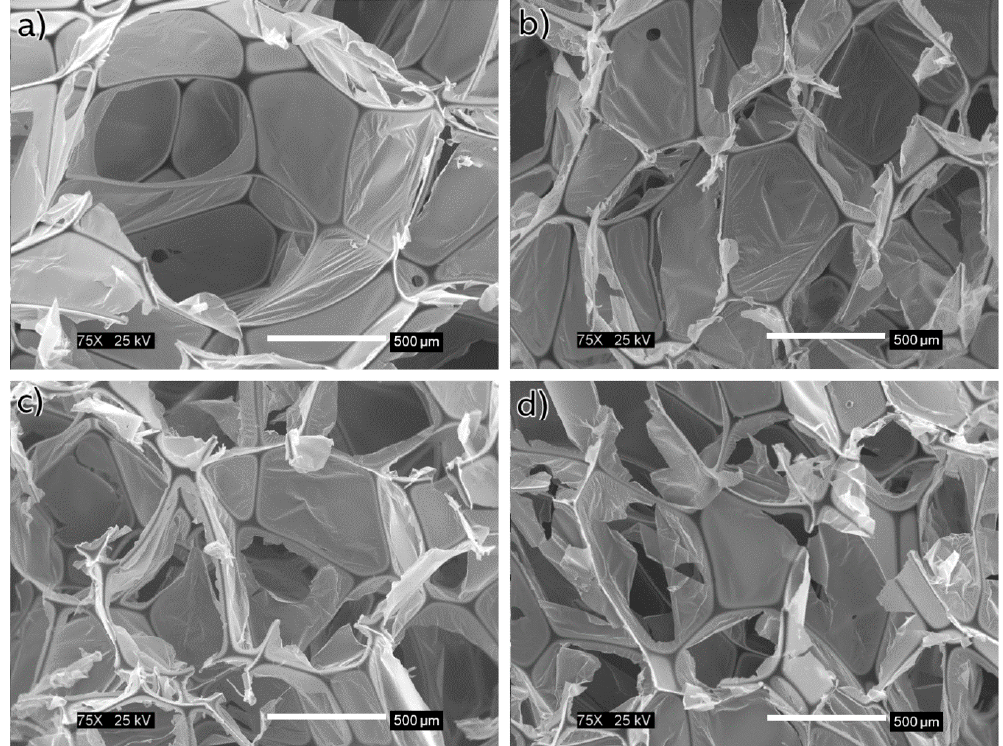
Figure 7. Scanning electron microscopy (SEM) images of foam samples: ( a ) as provided, ( b ) after one dynamic compression to 30% of its length, ( c ) after two dynamic compressions to 30% of the original length, and ( d ) after three dynamic compressions to 30% of its length.